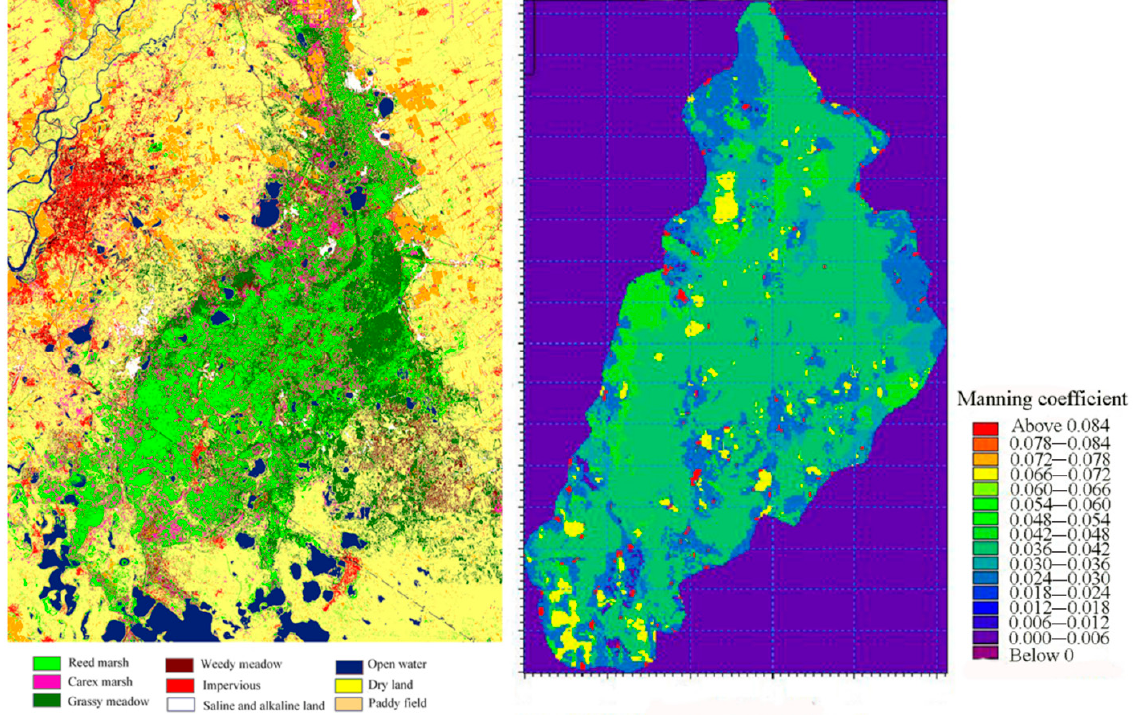
Figure 3. Land-cover map ( left ) and calibrated Manning coefficients ( right ). Table 2. Historical flooding events used for MIKE 21 hydrodynamic model calibration.